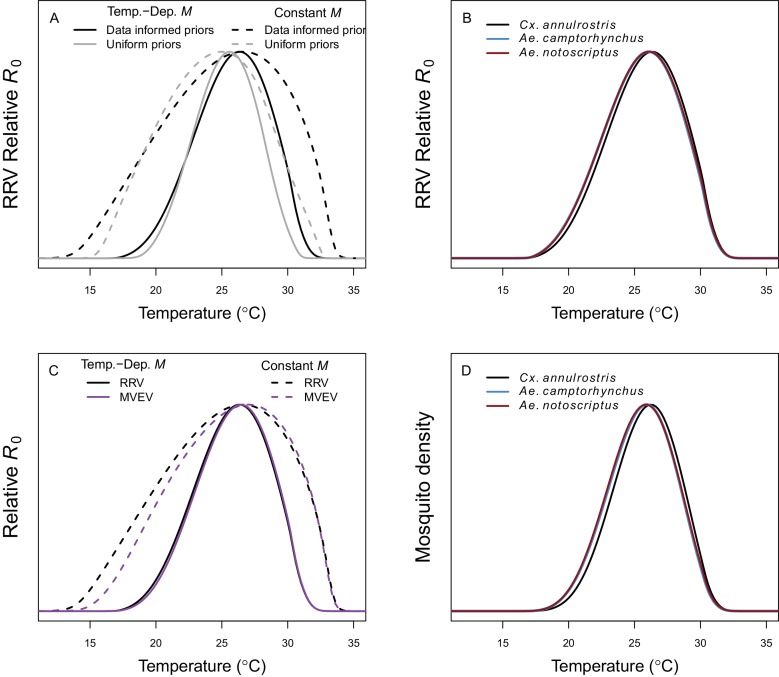
Thermal response of relative R0 using traits from alternative vectors.